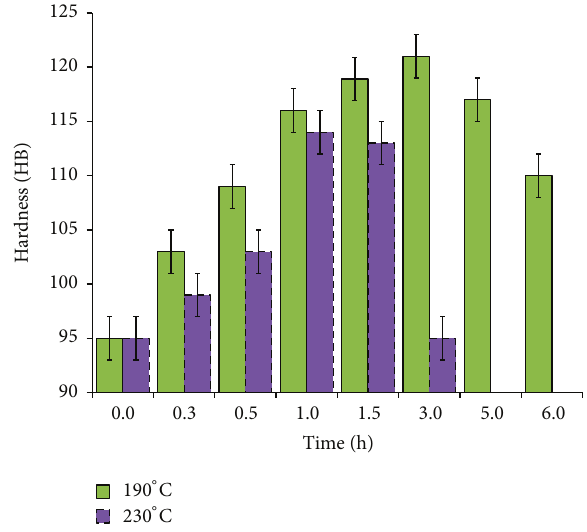
Figure 7: Curves for T6 temper for new alloy recycled Al4.8